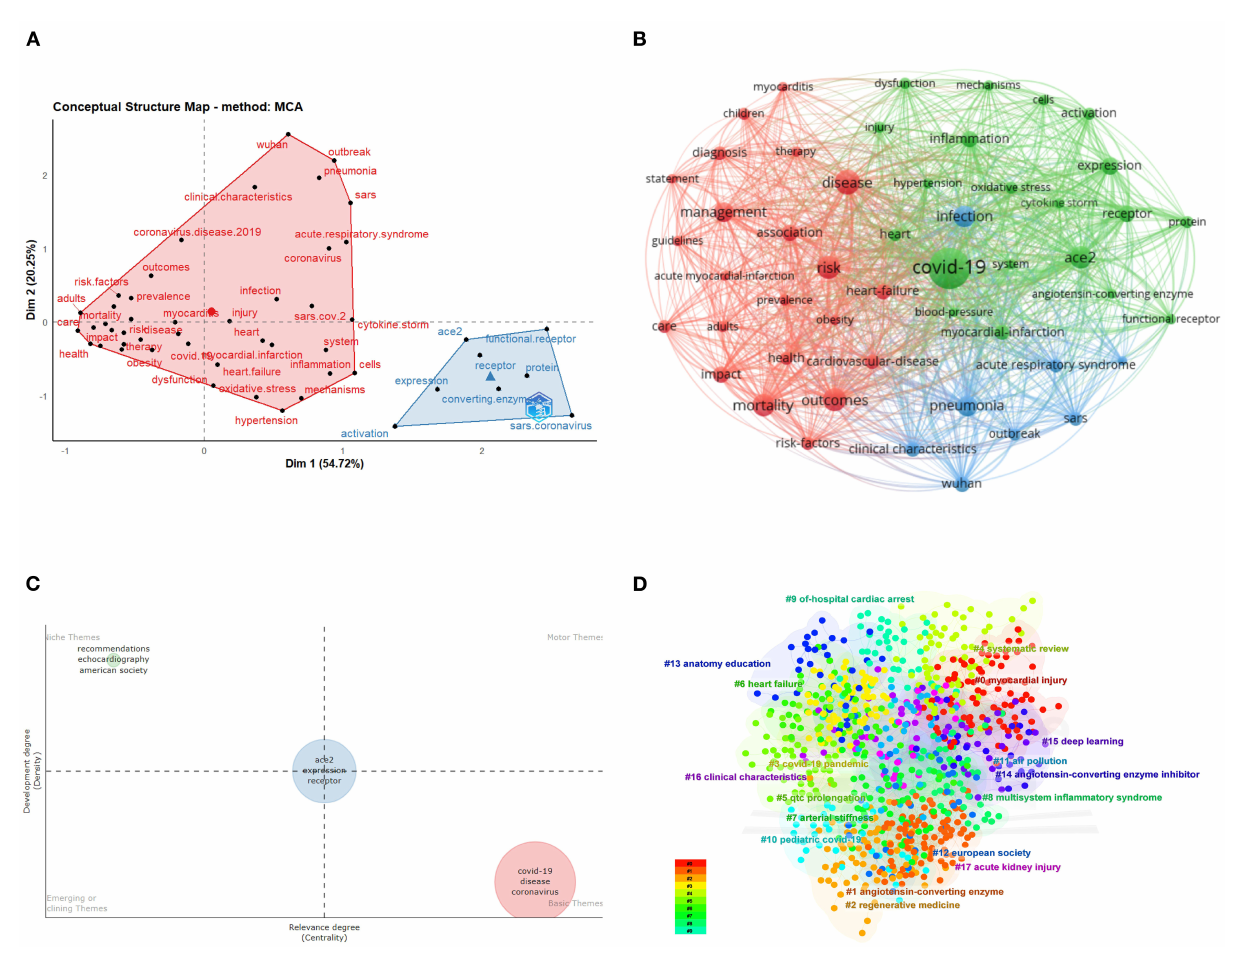
FIGURE5 Analysis of keywords in COVID-19-related CVD research. (A) Factorial analysis of keywords. (B) Cluster analysis of keywords associated with COVID-19-related CVD research. (C) Thematic network map of keywords. (D) Citespace network visualization map of co-occurring author